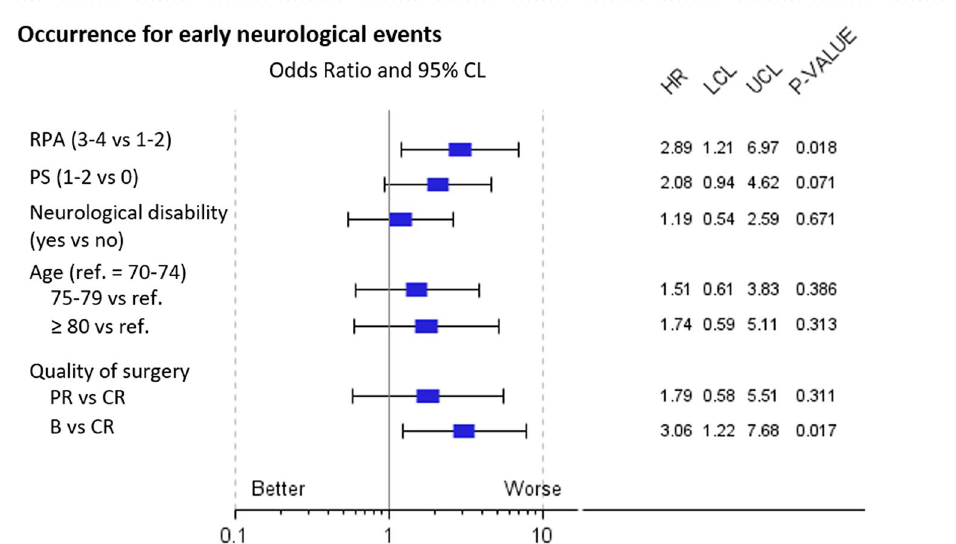
Figure 2. ( A ) Overall survival (OS) depending on the RPA class and ( B ) OS forest plot in univariate analysis. PS performance status, C ( P ) R complete (partial) resection, B biopsy. Neurological disability = pre- chemoradiation motor, visual, instability, cognitive or communication disability.